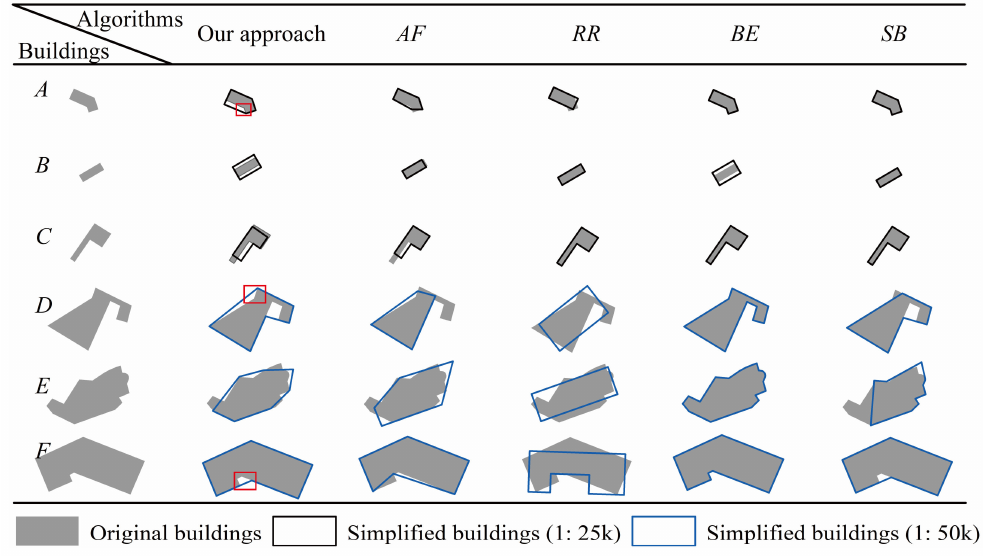
Figure 10. Comparison of typical buildings simplified using different simplification